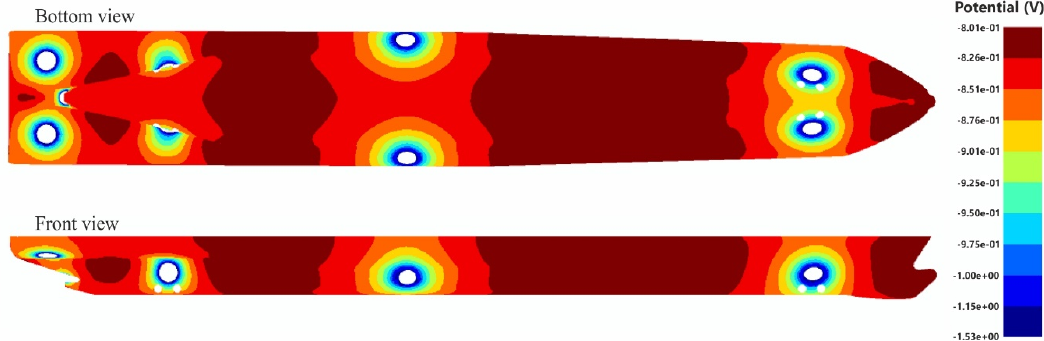
Figure 9. Potential distribution φ (V vs Ag/AgCl/seawater) at the steel hull.